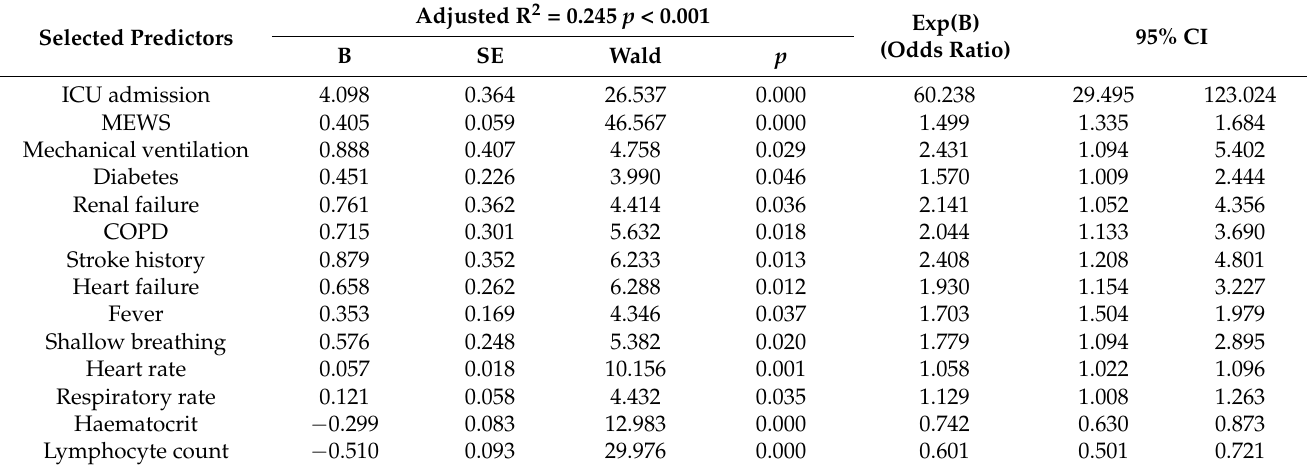
Table 3. Multivariate logistic regression analysis assessing the association between selected predictors and mortality of patients hospitalised with